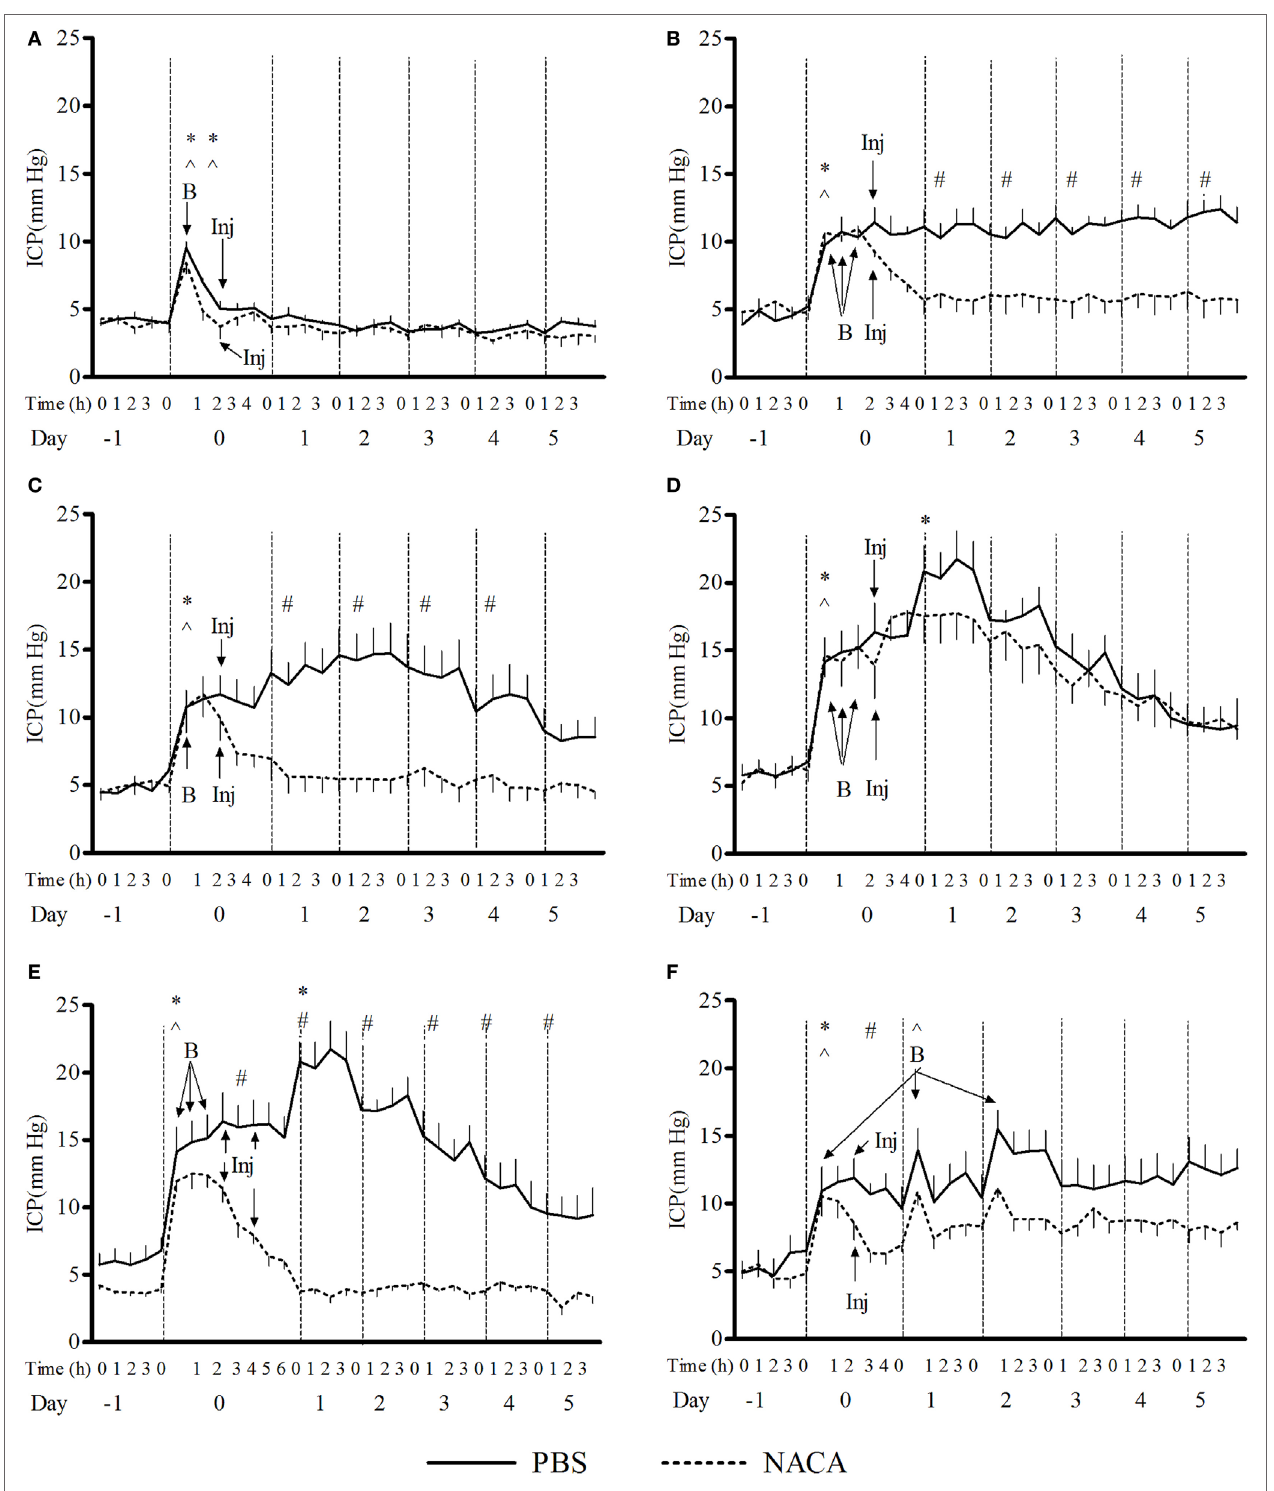
FigUre 1 | changes in intracranial pressure (icP) with various schedules of blast overpressure (BOP) exposure . Comparison between N -acetylcysteine amide (NACA)- and phosphate-buffered saline (PBS)-treated groups when administered after BOP exposure. (a) 1 × 72, (B) 3 × 72, (c) 1 × 110, (D) 3 × 110, (e) 3 × 110-2i, and (F) 3 × 110-3d. X -axis label is not to scale. B, blast; Inj, injection of NACA/PBS. Significant difference in ICP between a given time point and the one preceding it within a group is shown by * in PBS-treated and ^ in NACA-treated groups (one-way ANOVA); and between the two groups is shown by # (two-way RM ANOVA), with p < 0.05.